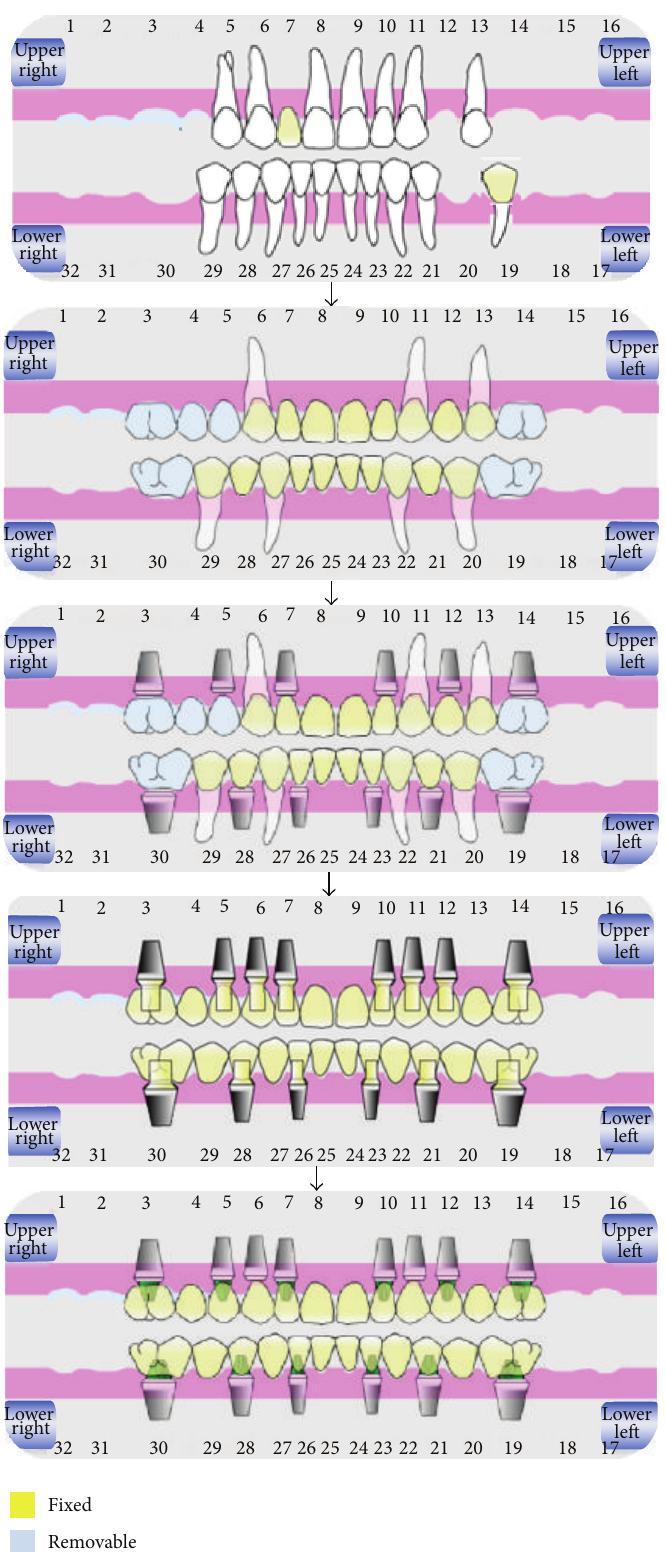
Figure 3: Schematic showing the steps of staged approach treatment